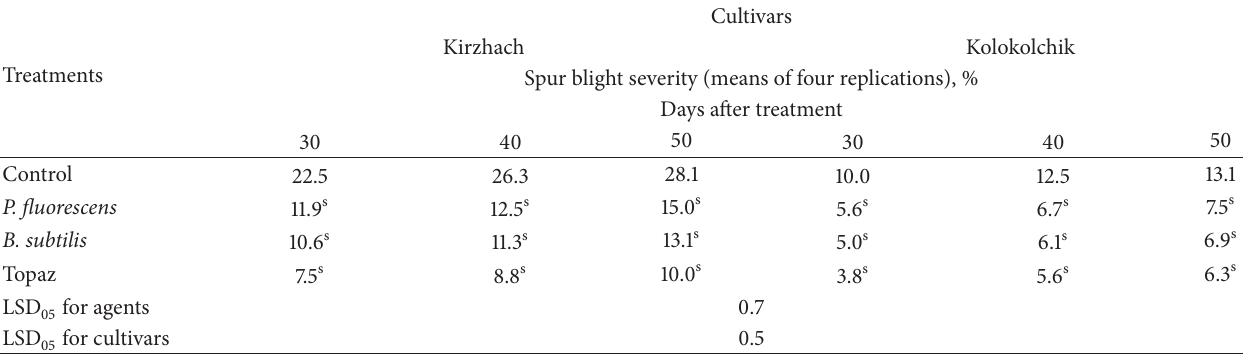
Table 5: Effect of the biocontrol agents on raspberry spur blight severity a , 2013.